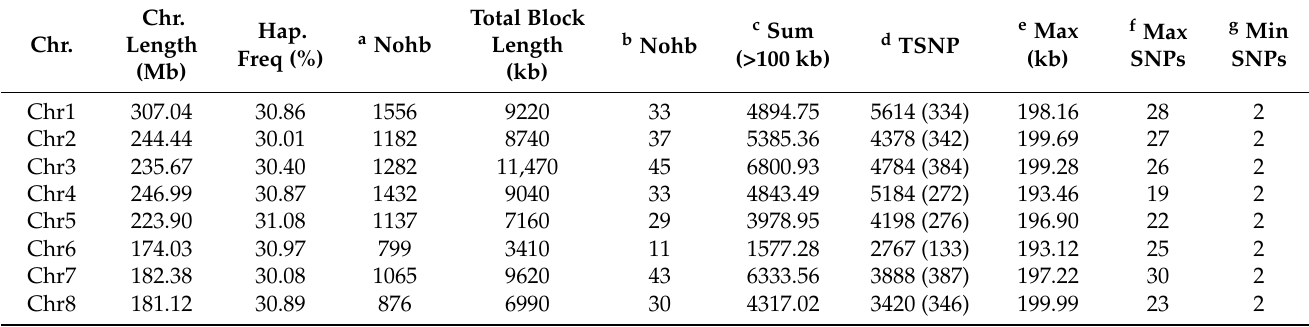
Table 3. The summary and distribution of haplotypes blocks on maize